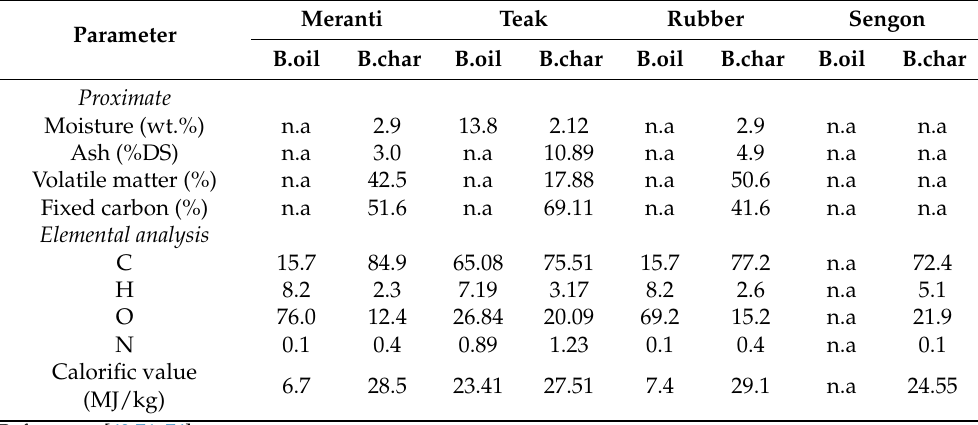
Table 5. Characteristics of biochar and bio-oil of meranti, teakwood, rubberwood, and sengon wood produced from